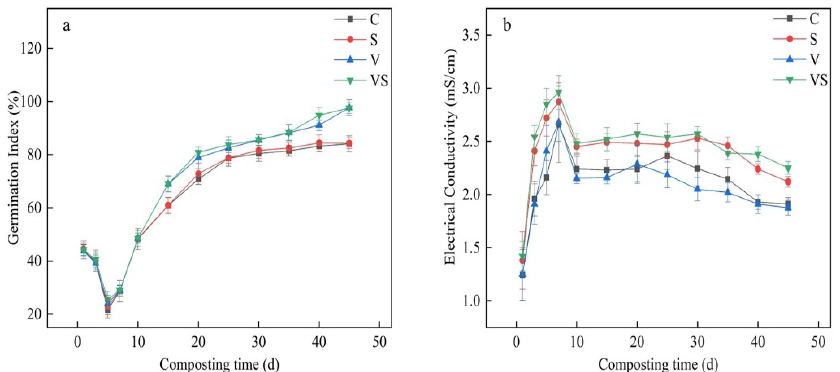
Figure 3. Changes in germination index ( a ) and electrical conductivity ( b ) of different experiment groups (control (C), ventilation (V), coral sand (S), ventilation and coral sand (VS)).